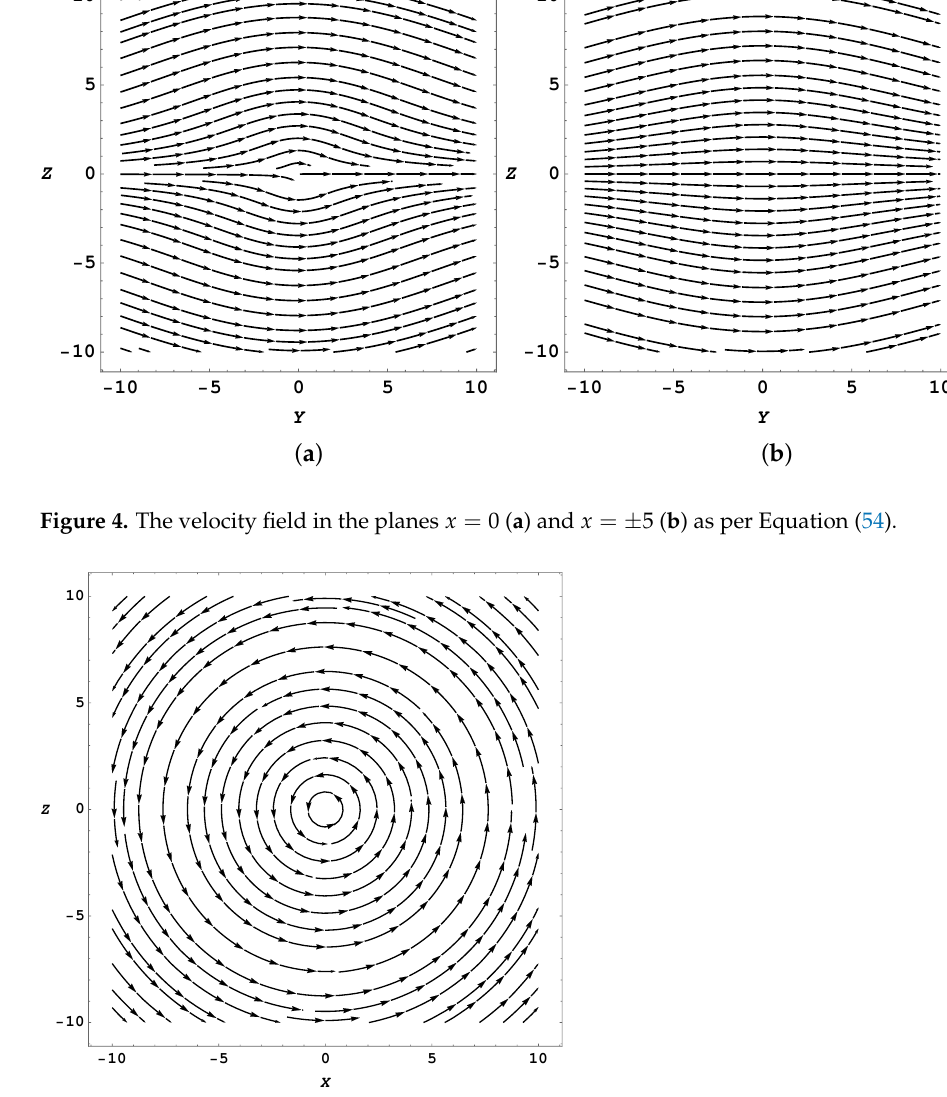
Figure 5. The vorticity field in the ( x , z ) -plane as per Equation